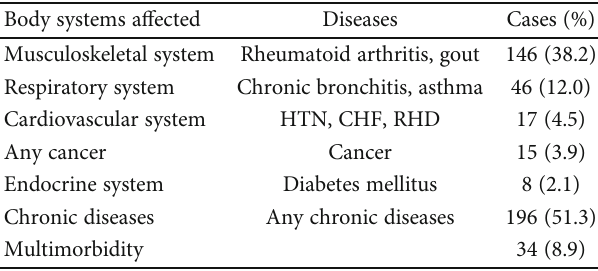
Table 3: Prevalence of chronic diseases by systems of the body among people living with HIV at HUCSH, April